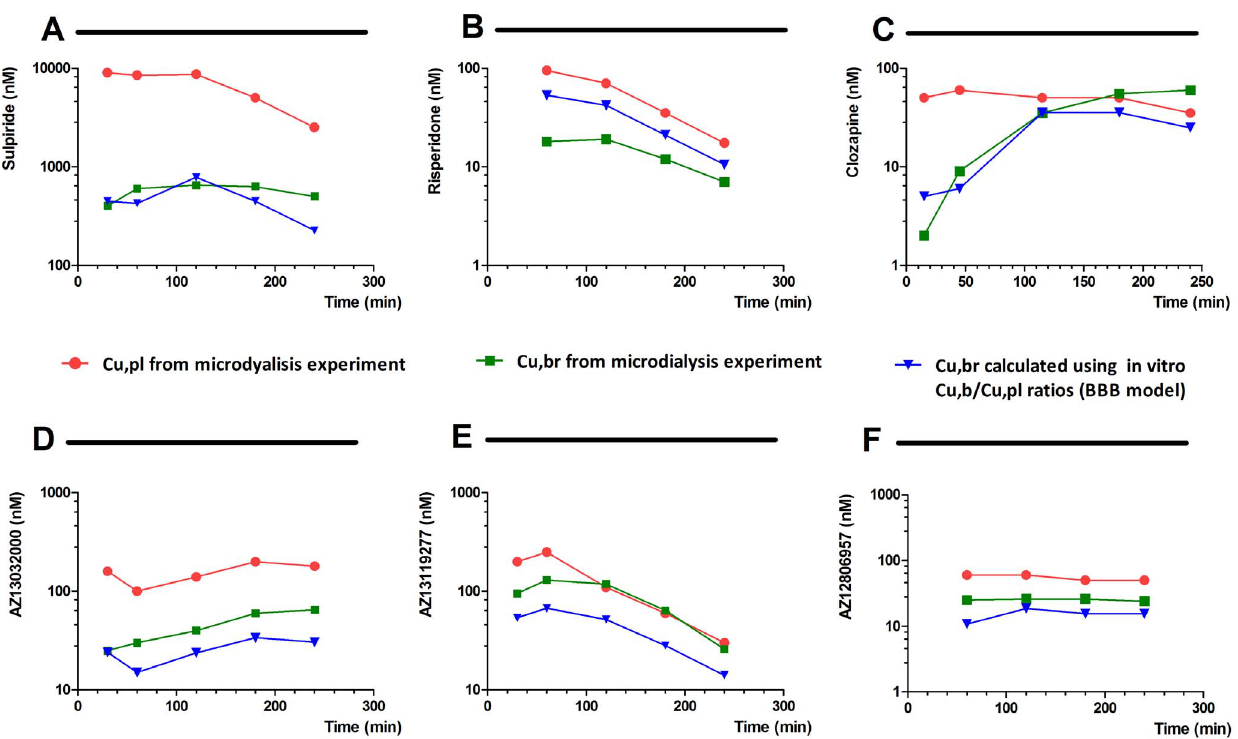
Figure 2. Free brain and plasma concentrations - time profile of three commercial compounds. Sulpiride (A), Risperidone (B), Clozapine (C) and 3 proprietary compounds (D, E and F) determined by brain microdialysis and compared with free brain concentrations obtained by multiplying the free plasma concentration from the microdialysis experiment with Cu,b/Cu,p ratios obtained in vitro using the in vitro BBB model. Free plasma concentration at earlier time point than 1 hour were used together with in vitro Cu,br/Cu,pl ratio at 1 h and microdialysis plasma concentration data at 2 hours and beyond were multiplied by the in vitro steady state ratio to simulate the microdialysis profile. Values for drugs are defined in Table 2 and values for proprietary compounds in Table 3.